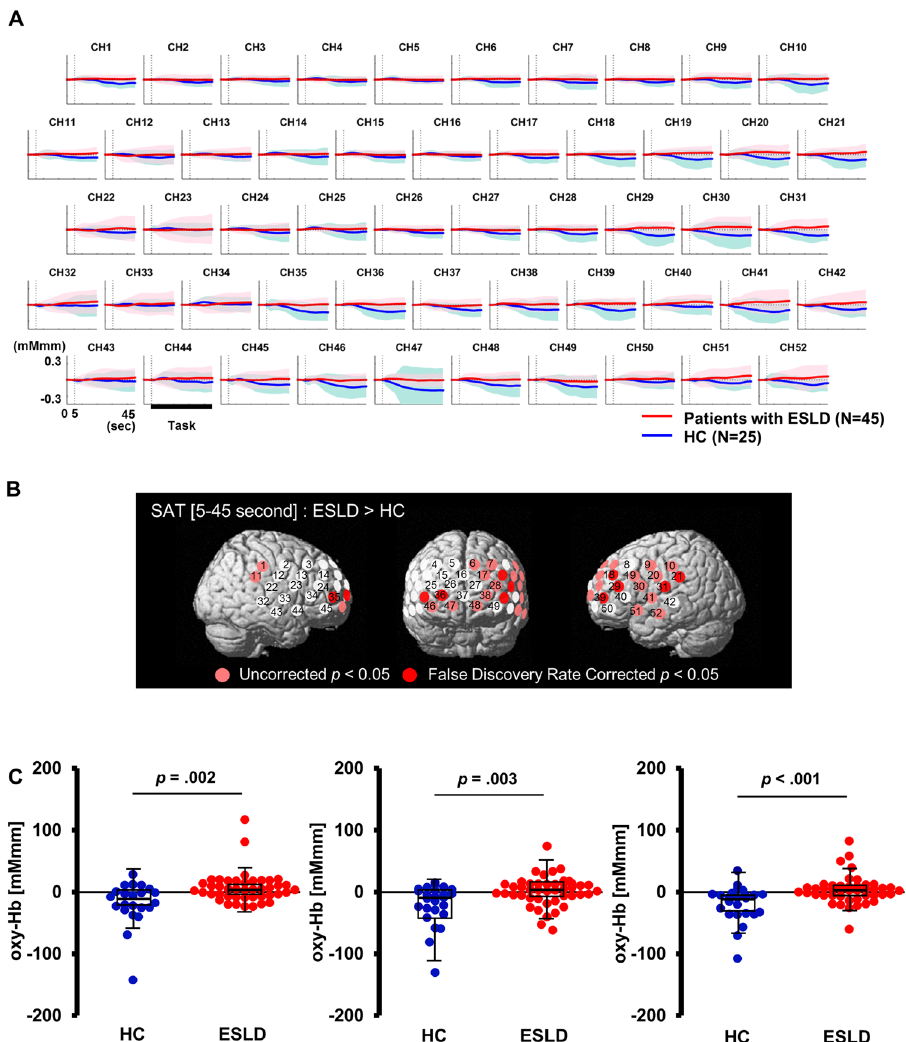
Figure 3. Differences between patients with end stage liver disease (ESLD) and healthy controls (HC) in the sustained attention task (SAT). ( A ) The graphs show oxygenated hemoglobin ([oxy-Hb]) concentration change during the SAT. Standard deviations for each group are shown with thick bands. ( B ) Channels on the 3D topographic maps indicate differences in [oxy-Hb] integral value between patients with ESLD and HC (pink circles: p < 0.05 false discovery rate uncorrected, red circles: p < 0.05 false discovery rate corrected). ( C ) The graphs show differences of [oxy-Hb] integral value between HC and patients with ESLD in channel29: left inferior frontal gyrus (left); channel 35: right inferior frontal gyrus (middle); and channel 36: right middle frontal gyrus (right). The upper and lower borders of the box plot marks the 75th and 25th percentiles, respectively and the middle line indicating the median value. Whiskers above and below the box indicate the highest datum still within 1.5 interquartile range (IQR) of the upper quartile, and the lowest datum still within 1.5 IQR of the lower quartile, respectively. * p < 0.05, ** p < 0.01 determined by t-tests with equal